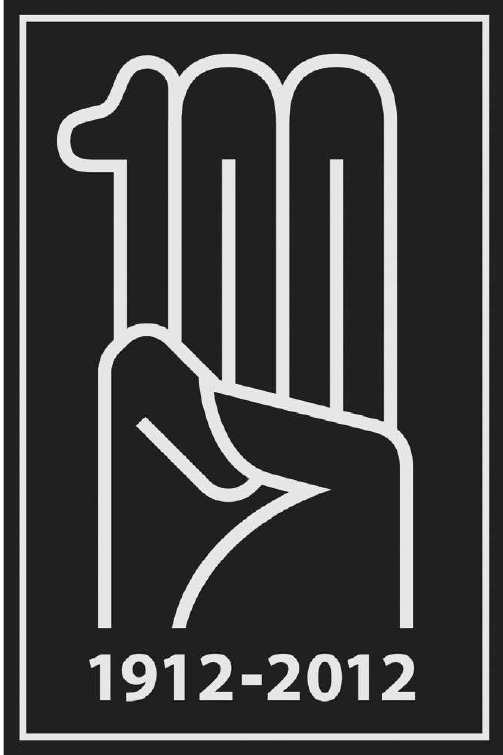
Source: http://www.mi chelapovoleri.com/ Fig. 10. Ça (cid:249) lar Okur: 100th Anniversary of Turkish Scouts Emblem and